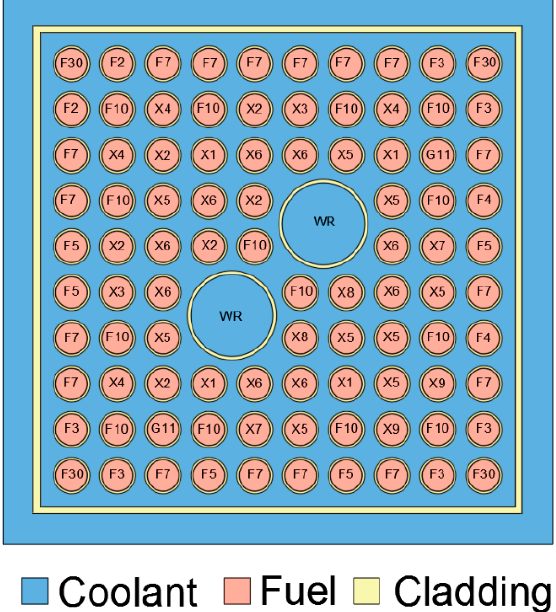
Figure 1. Horizontal 2D 10 × 10 fuel assembly map of each pin type based on an edited version of a patent filed by Global Nuclear Fuel-Americas [33].